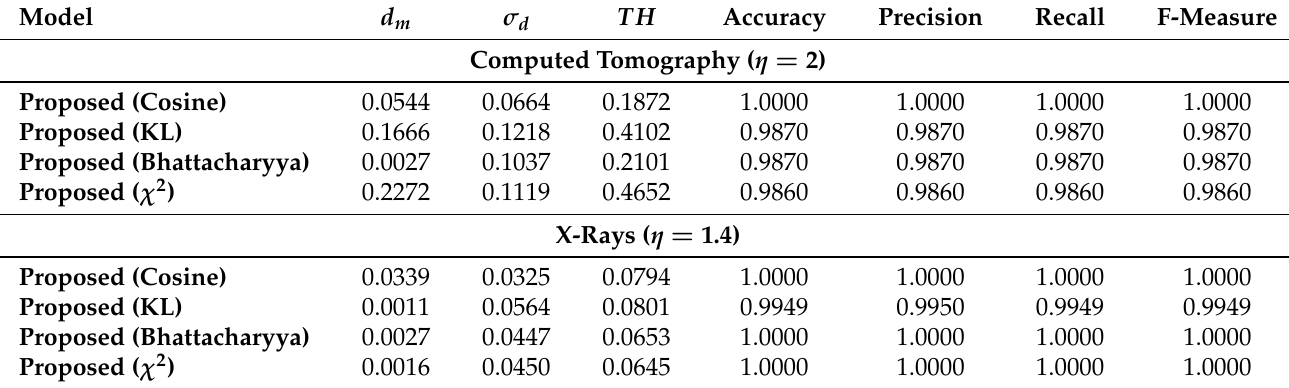
Table 4. Results obtained by the proposed approach under the two considered datasets. The results have been obtained by using N T = 500 reference images from the CP class and a number N bin = 50 of histogram